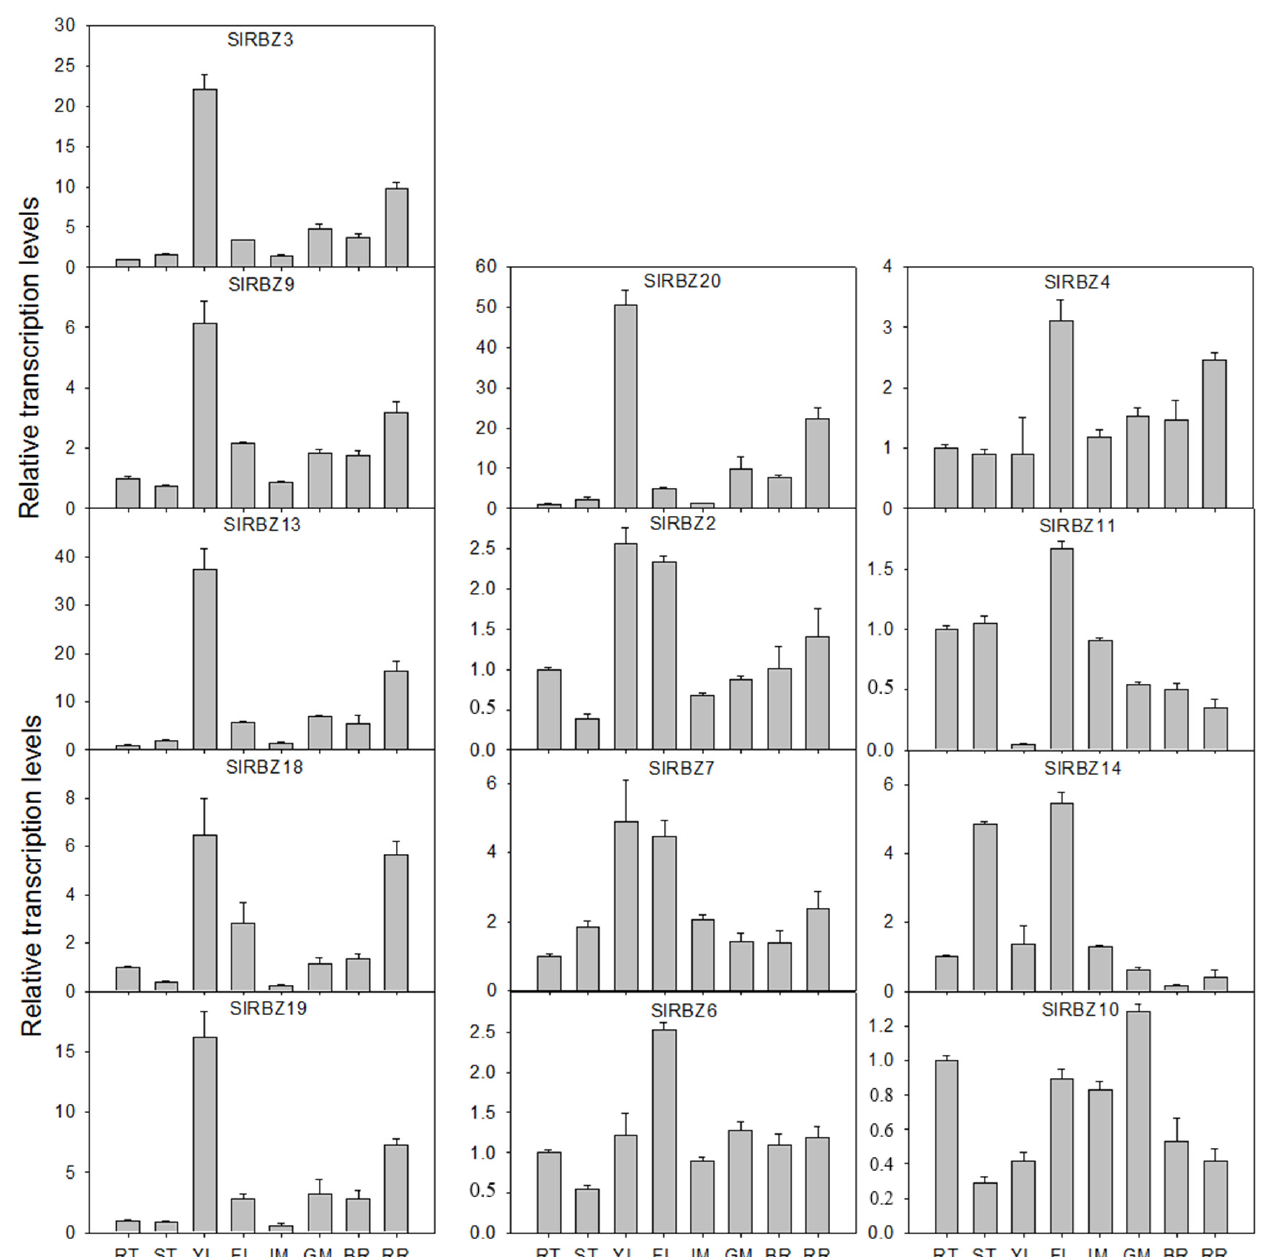
Figure 6. Expression profiles of SlRBZ genes in different tissues and organs. RT, root; ST, stem; YL, young leaf; FL, flower; IM, pericarp of immature fruit; GM, pericarp of mature green fruit; BR, pericarp of breaker fruit; RR, pericarp of red ripe fruit. Error bars represent standard deviations for the three replicates.